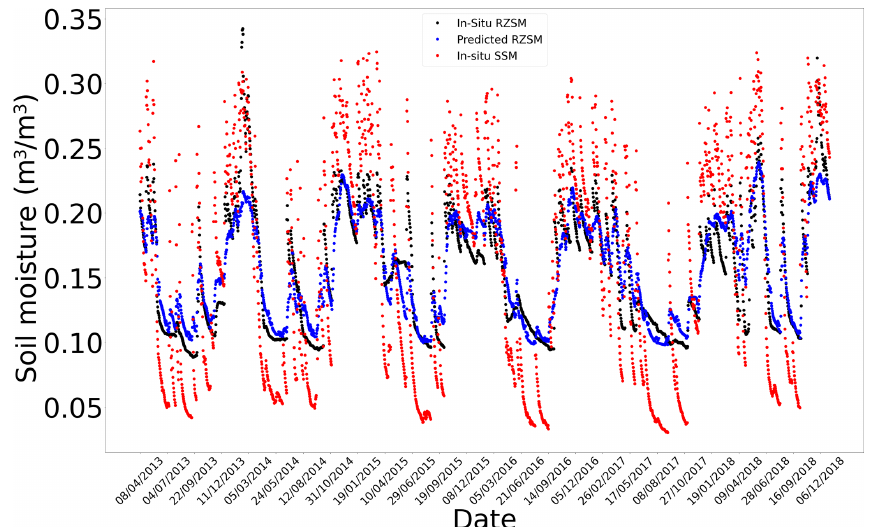
Figure E6. In situ SSM, in situ RZSM, and predicted RZSM series at station Cabrieres D’Avignon (SMOSMANIA) with